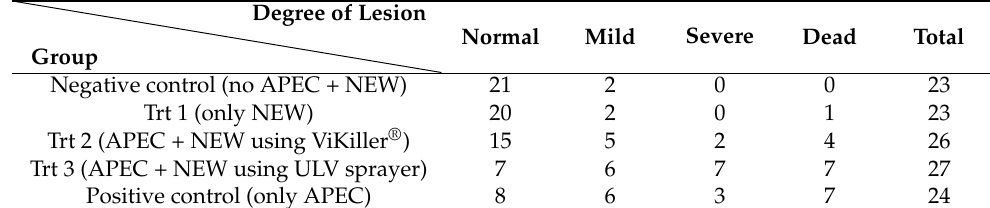
Table 2. Data for the lesions and mortality rates by APEC in experimental layers.